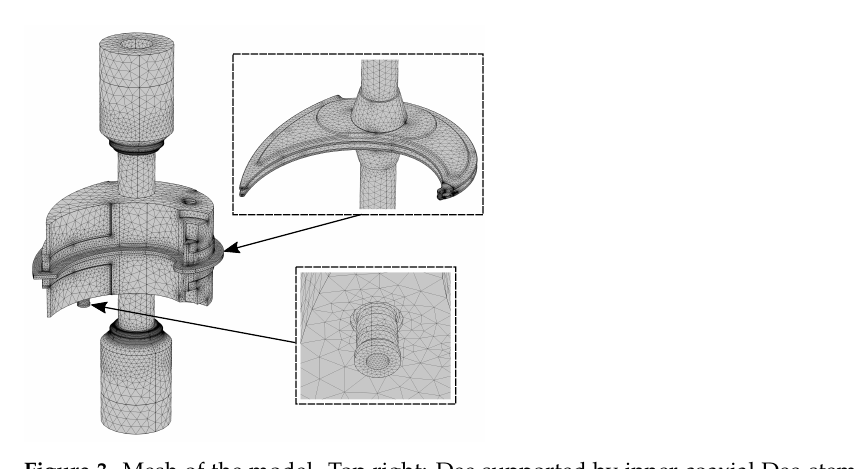
Figure 3. Mesh of the model. Top right: Dee supported by inner coaxial Dee-stem. Bottom right: external part of the